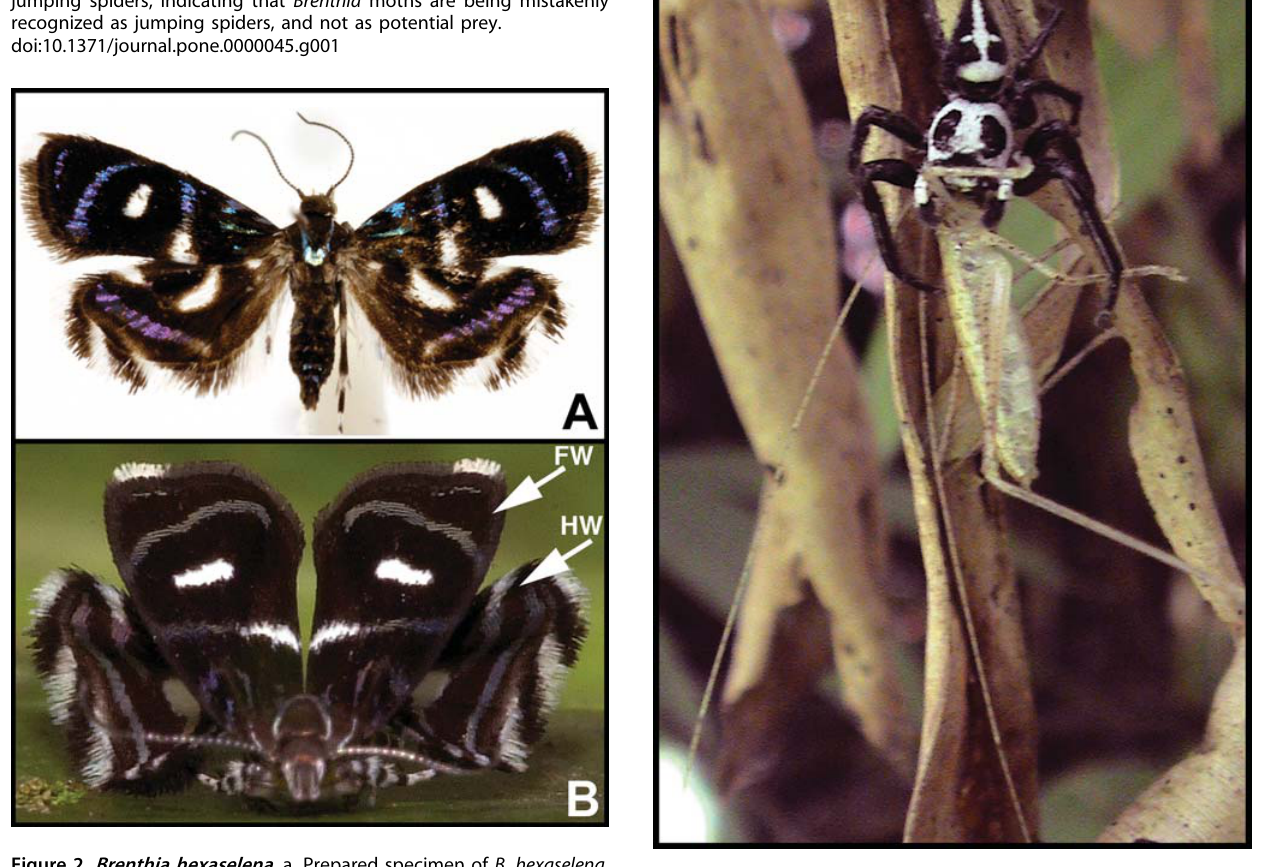
Figure 2. Brenthiahexaselena . a, Prepared specimen of B. hexaselena . b, Live B. hexaselena , FW – forewing, HW – hindwing. Figure 3. Phialeformosa .